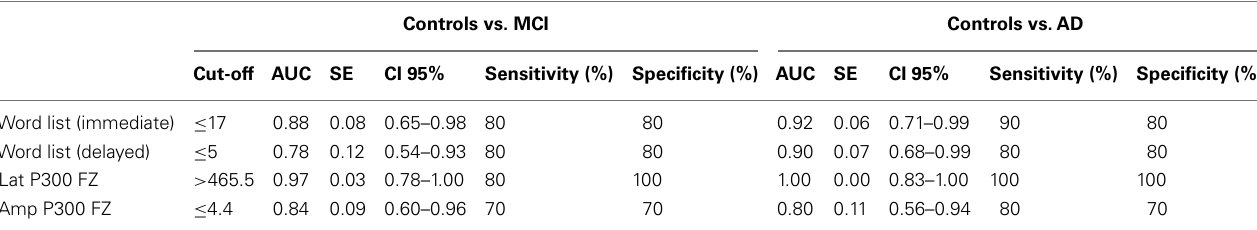
Table 3 | Results of the ROC analysis with the variables which resulted in significant differences in group comparisons. Controls vs. MCI Controls